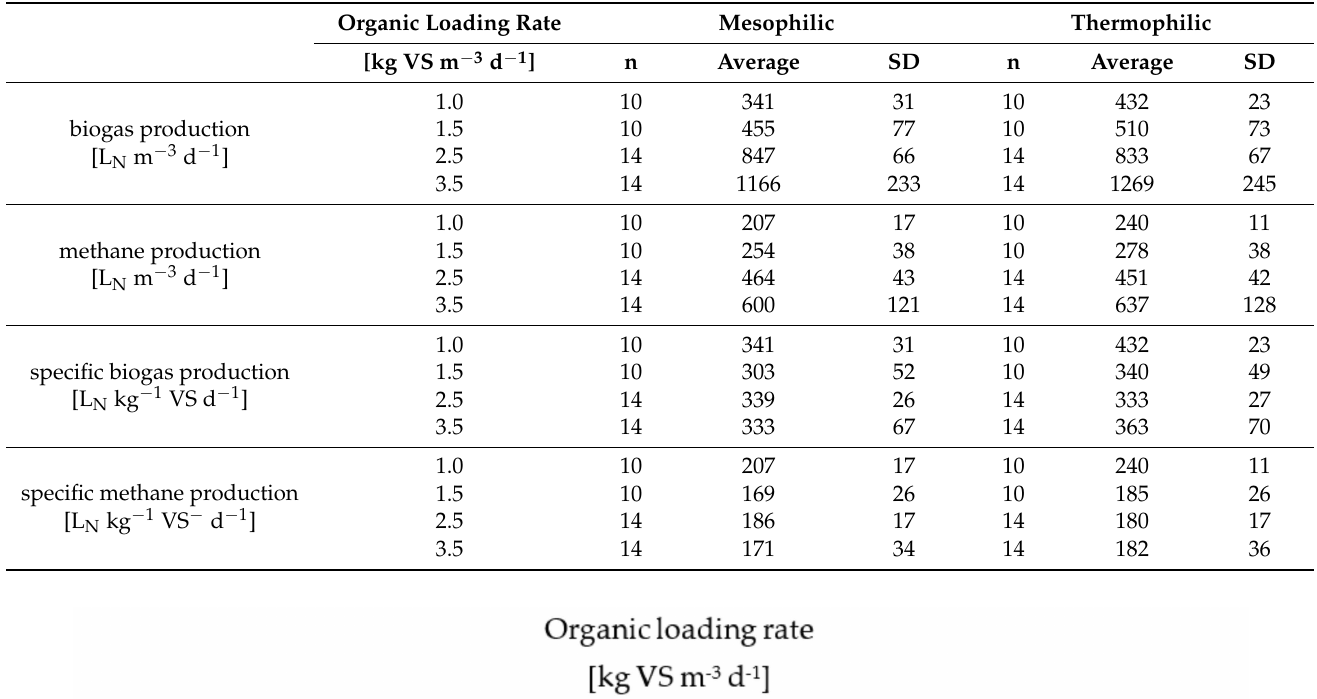
Table 4. The values of the volumetric gas and specific gas production rates under the steady state conditions of the reactors.